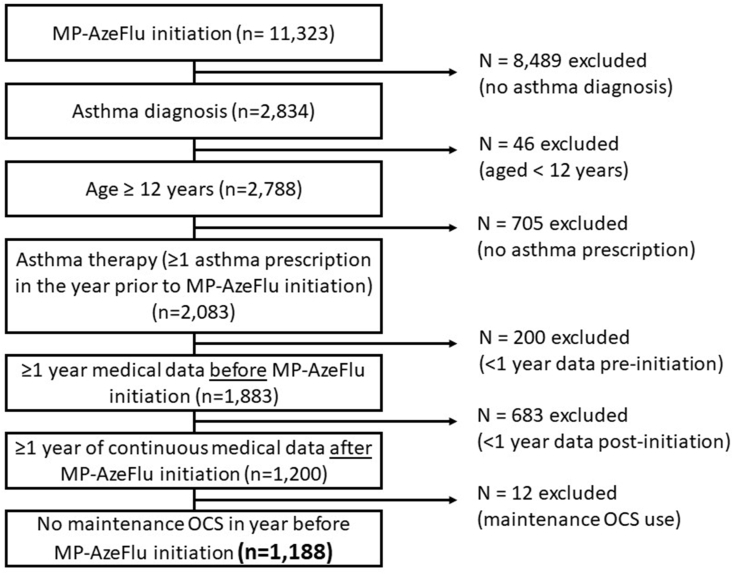
Subject disposition. Patients within the Optimum Patient Care Database who fulfilled study inclusion criteria. OCS: oral corticosteroids